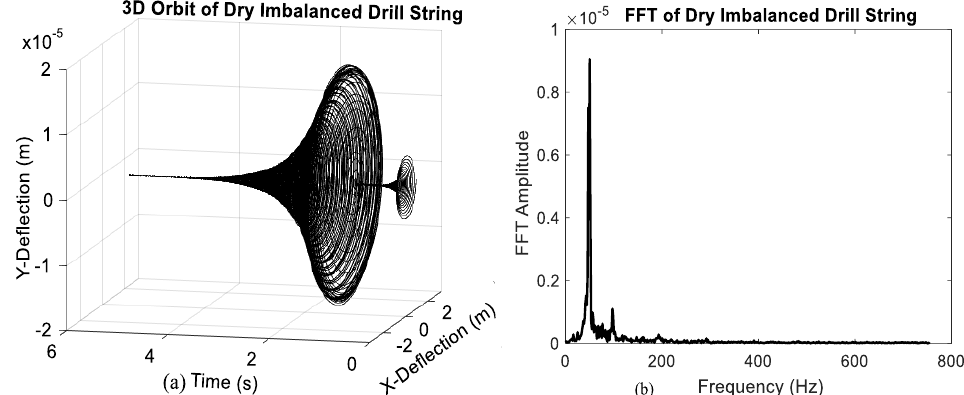
Figure 8. Response of the imbalanced drilling system while passing its first critical speed. ( a ) 3D imbalance response orbit in air; ( b ) FFT response of imbalanced drill in air.